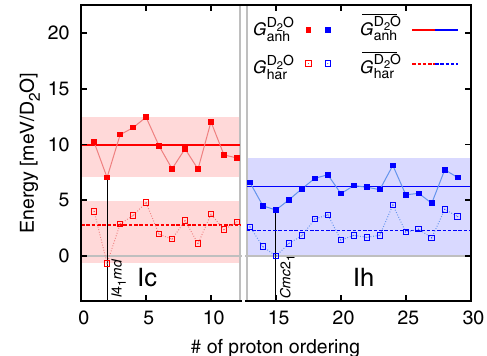
FIG. 5. Zero temperature G D 2 O (empty squares, lower part) and har G D 2 O (filled squares, upper part) for different deuterated Ih (blue) anh and Ic (red) proton orderings. The averages over proton orderings G D 2 O and G D 2 O are shown as thick dotted and solid lines, har anh respectively. All energies are measured with respect to G D 2 O of Ih Cmc 2 1